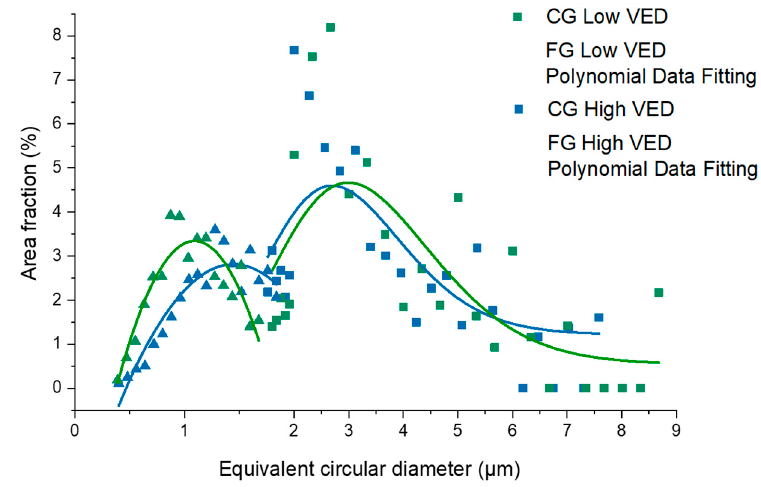
Figure 5. Grain size distribution for coarse (CG) and fine (FG) grain material for low- and high-VED as-built samples.